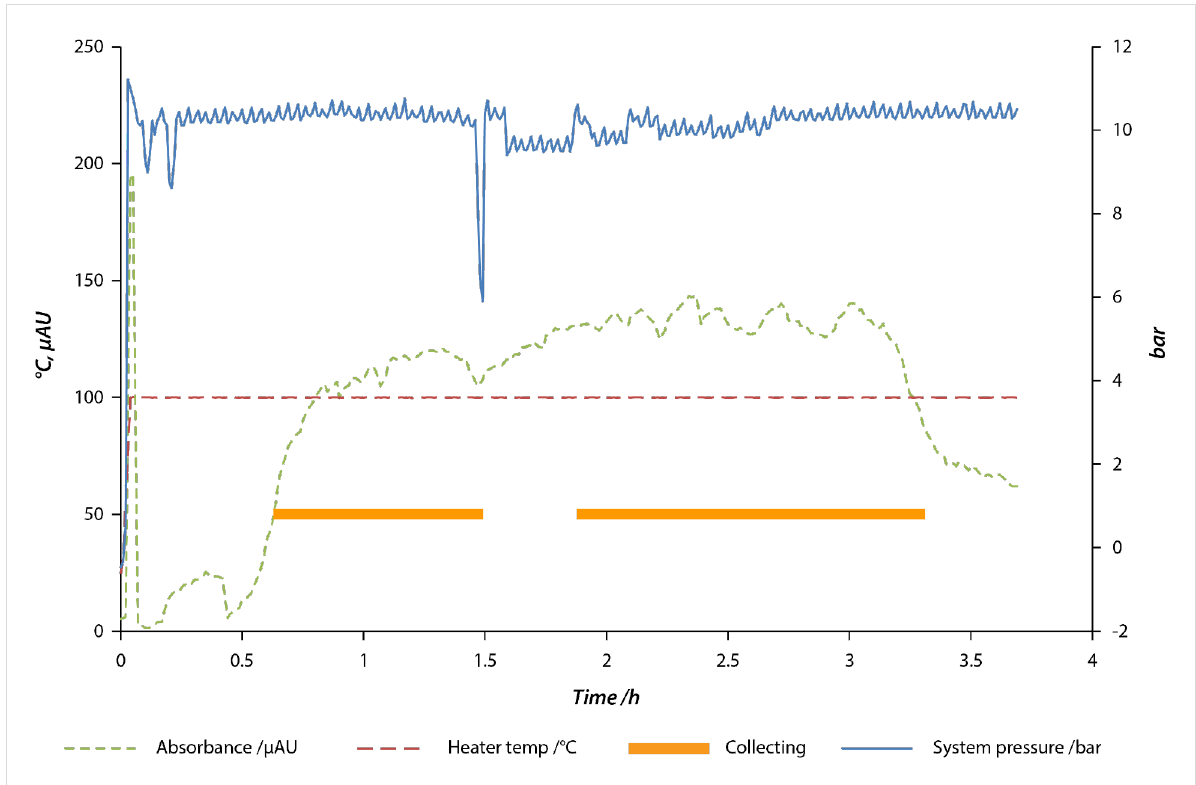
Figure 7: Profile for a 3 hour reaction simulating a long run. The absorbance shown is that at 1685 cm − 1 , which is indicative of the amide bond in 2 . The nitrile stretching absorbance at 2245 cm − 1 was not observed. The thick bar represents the time over which valve V1 is set to collect the output as opposed to directing it to waste. The pressure drop at 1.5 h, caused by a bubble in the inlet stream, triggered the system to send the effluent to waste until a predetermined wait time – corresponding to one column volume – elapsed after the pump had been manually